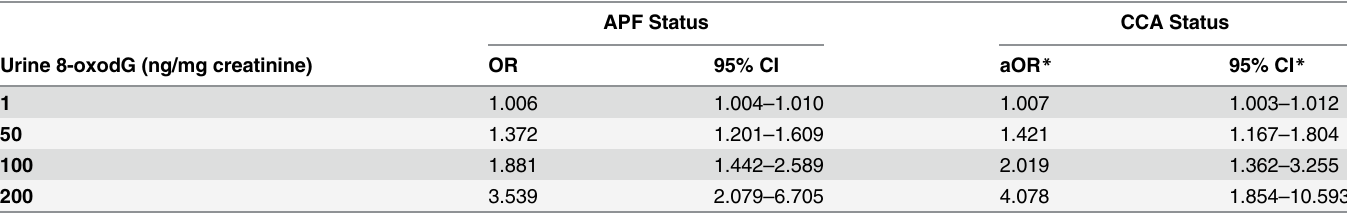
Table 2. Progressively higher urinary 8-oxodG levels show an increasing risk of having received a clinical diagnosis of APF+ or CCA status in Opisthorchis viverrini infected individuals.